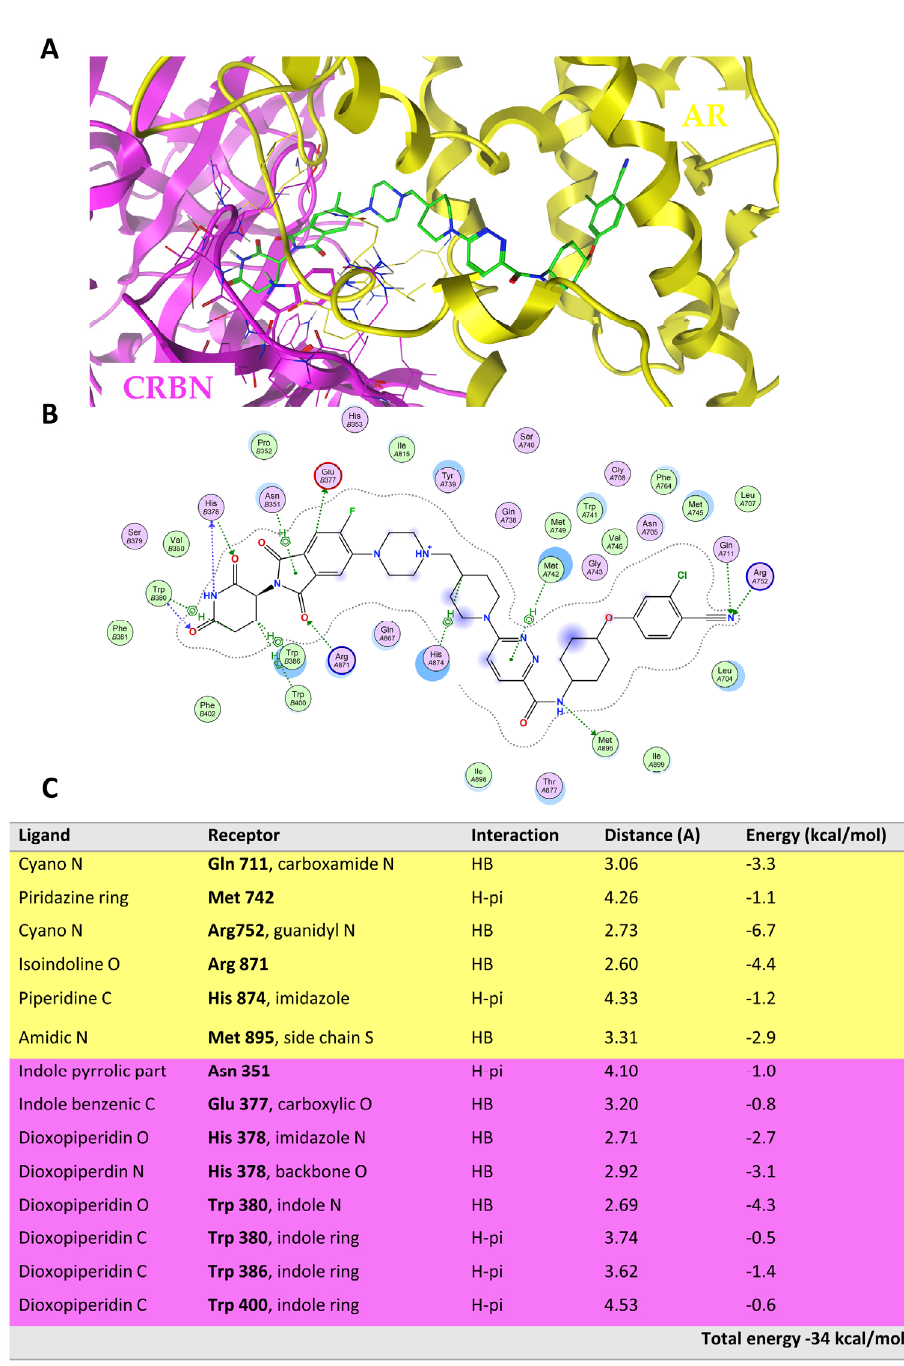
Figure 5. ( A ) The ternary complex is shown. ARV-110 is shown in green, AR is shown in yellow, and CRBN is shown in light violet. ( B ) Ligand interaction chart. ( C ) Interaction table highlighting the main interactions between ARV-110 AR (yellow) and CRBN (light violet).